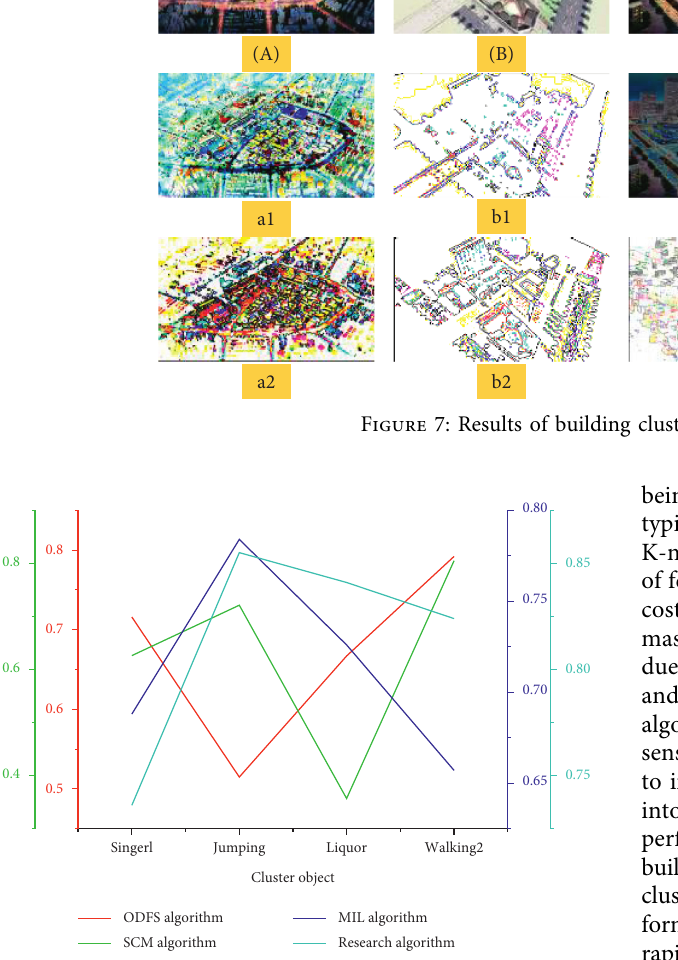
Figure 8: Success rate comparison